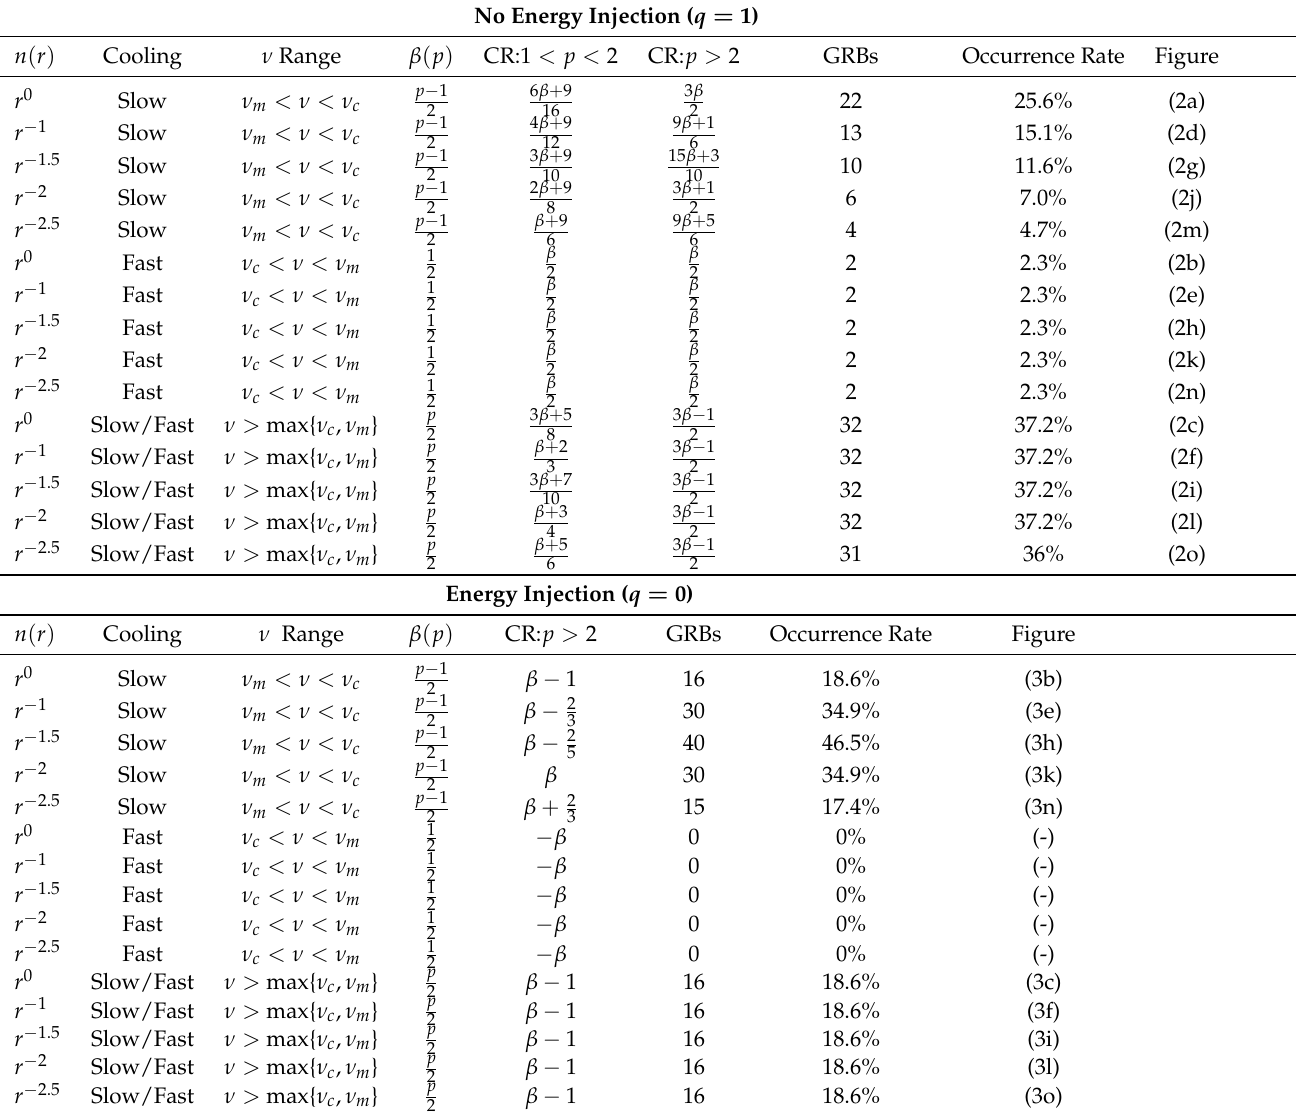
Table 3. Summary of results of the CRs obtained with observed data without energy injection ( q = 1; top) and with energy injection ( q = 0; bottom), showing number and occurrence rate of GRBs satisfying each relation, out of a total of 86 GRBs. As each occurrence rate is computed independently from the total sample of 86 GRBs, the rates are not required to sum to 100%. No Energy Injection ( q =